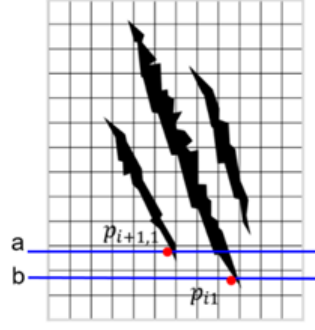
Figure 3. The process of row-by-row